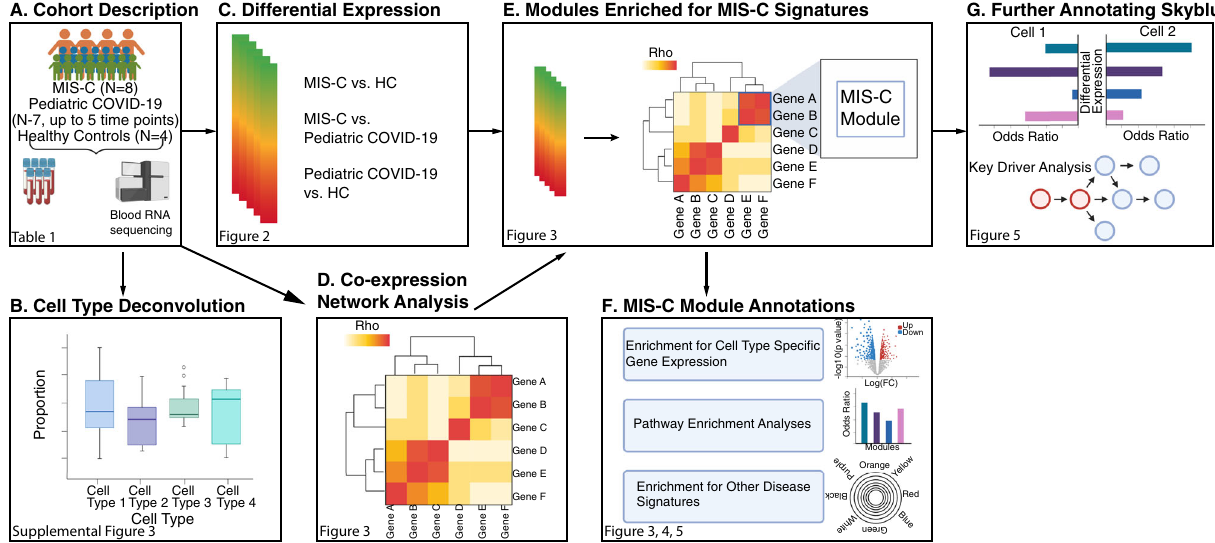
Fig. 1 Study overview. Work fl ow of the analyses presented in the paper. A RNA-seq was generated on whole blood samples from MIS-C cases, pediatric COVID-19 cases, and healthy controls. B Deconvolution estimated the relative cell-type proportions in each transcriptome, which were compared between cases and controls to identify the immune cell types involved in the pathogenesis of MIS-C. C Expression of each gene in the transcriptome was tested for association with disease, resulting in a MIS-C signature that was queried to resolve the dysregulated molecular pathways. D Co-expression